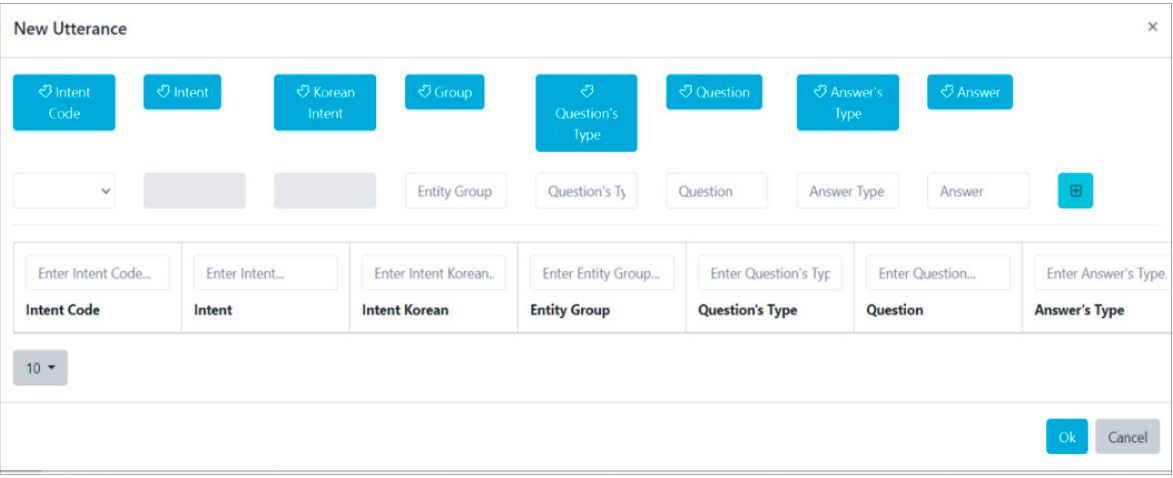
Figure 13. Input interface of chatbot utterance data.